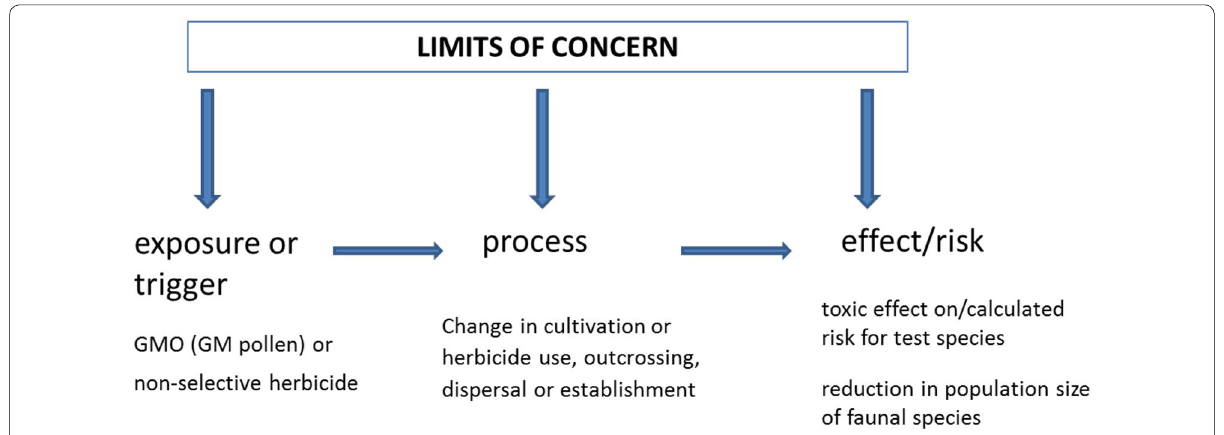
Fig. 1 Options for setting LoCs for genetically modified plants. modified after